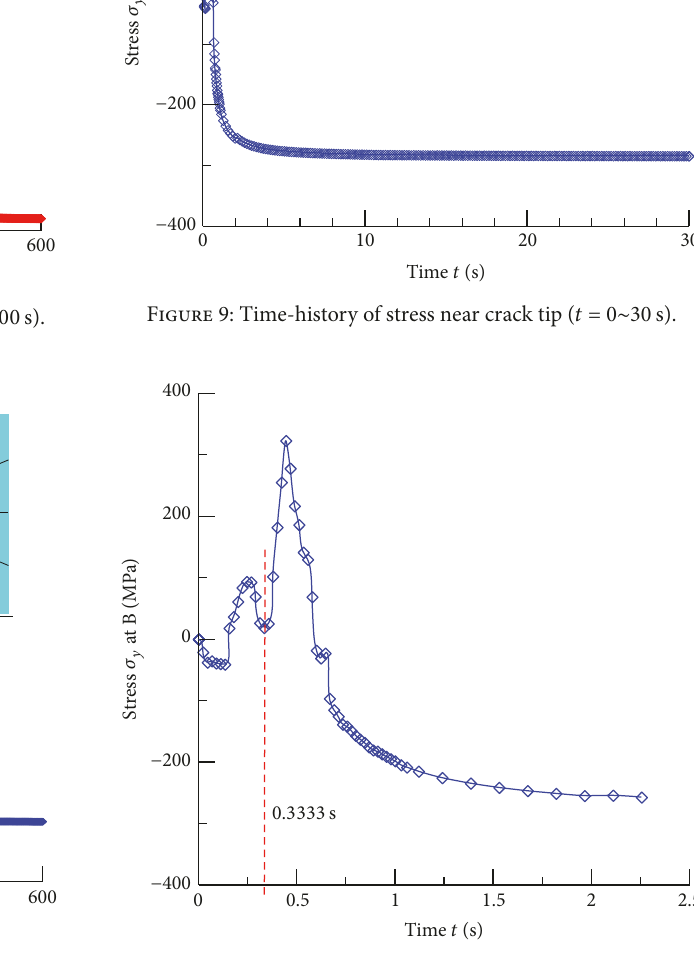
Figure 8: Time-history of stress near crack tip ( 𝑡 = 0 ∼ 600 s).